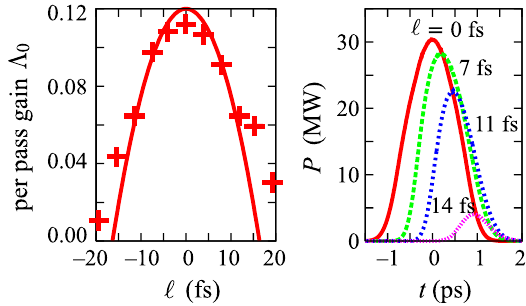
FIG. 2. (Color) Effect of timing mismatches between the elec- tron beam and the radiation, i.e., detuning, for the 12-keV ¼ 1 ps . The first graphs the example from Table I, with (cid:2) e single-pass gain measured from the 1D simulation (crosses) and from the supermode theory (lines). The second plots the longitudinal pulse profile after saturation for four different values of the detuning ‘ . We see only modest pulse distortion and power reduction for ‘ & 10 fs , corresponding to a cavity length detuning of 1 : 7 (cid:10) m